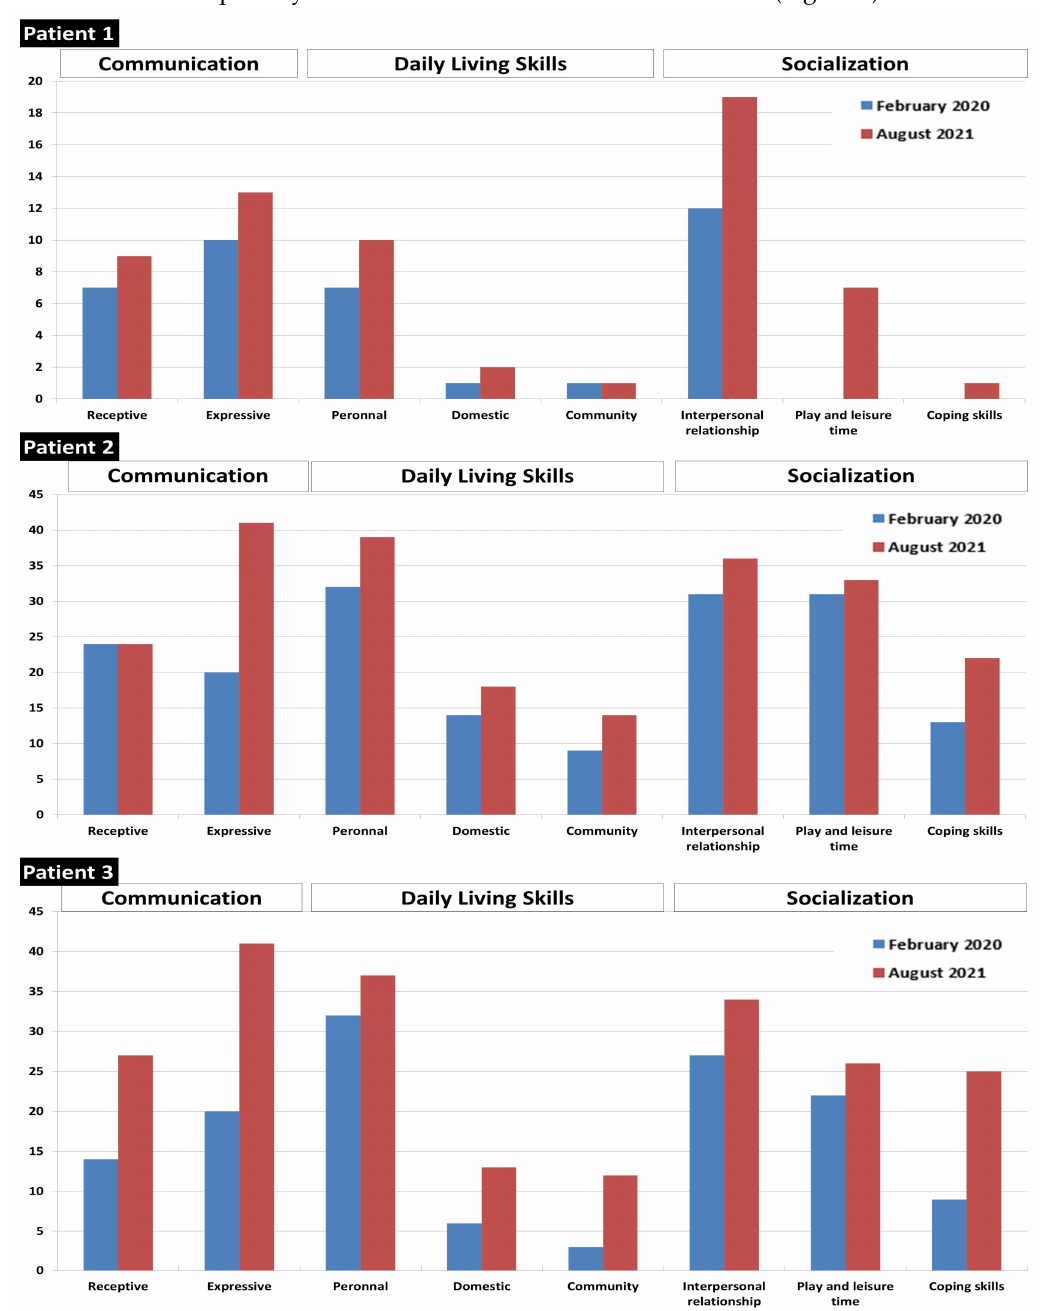
Figure 6. Vineland score before and after 18 months of treatment with high-protein diet and BCAA